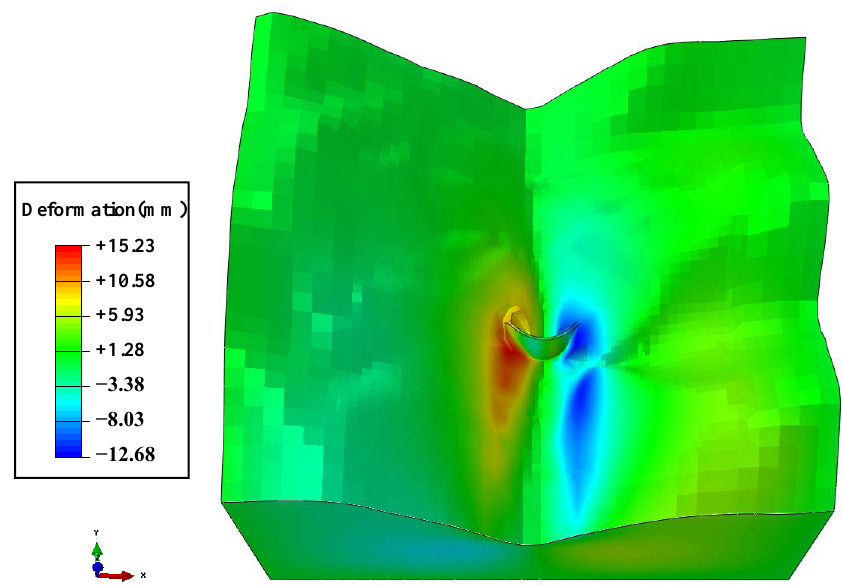
Figure 26. Numerical calculation results of the valley’s tangential deformation.